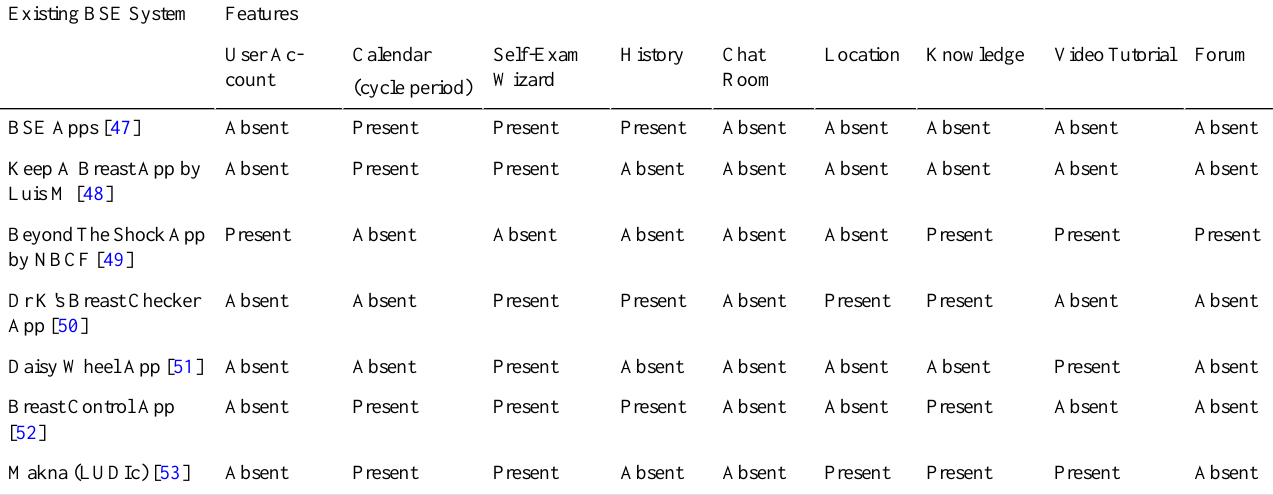
Table 1. Comparison of currently available breast self-examination (BSE) systems.